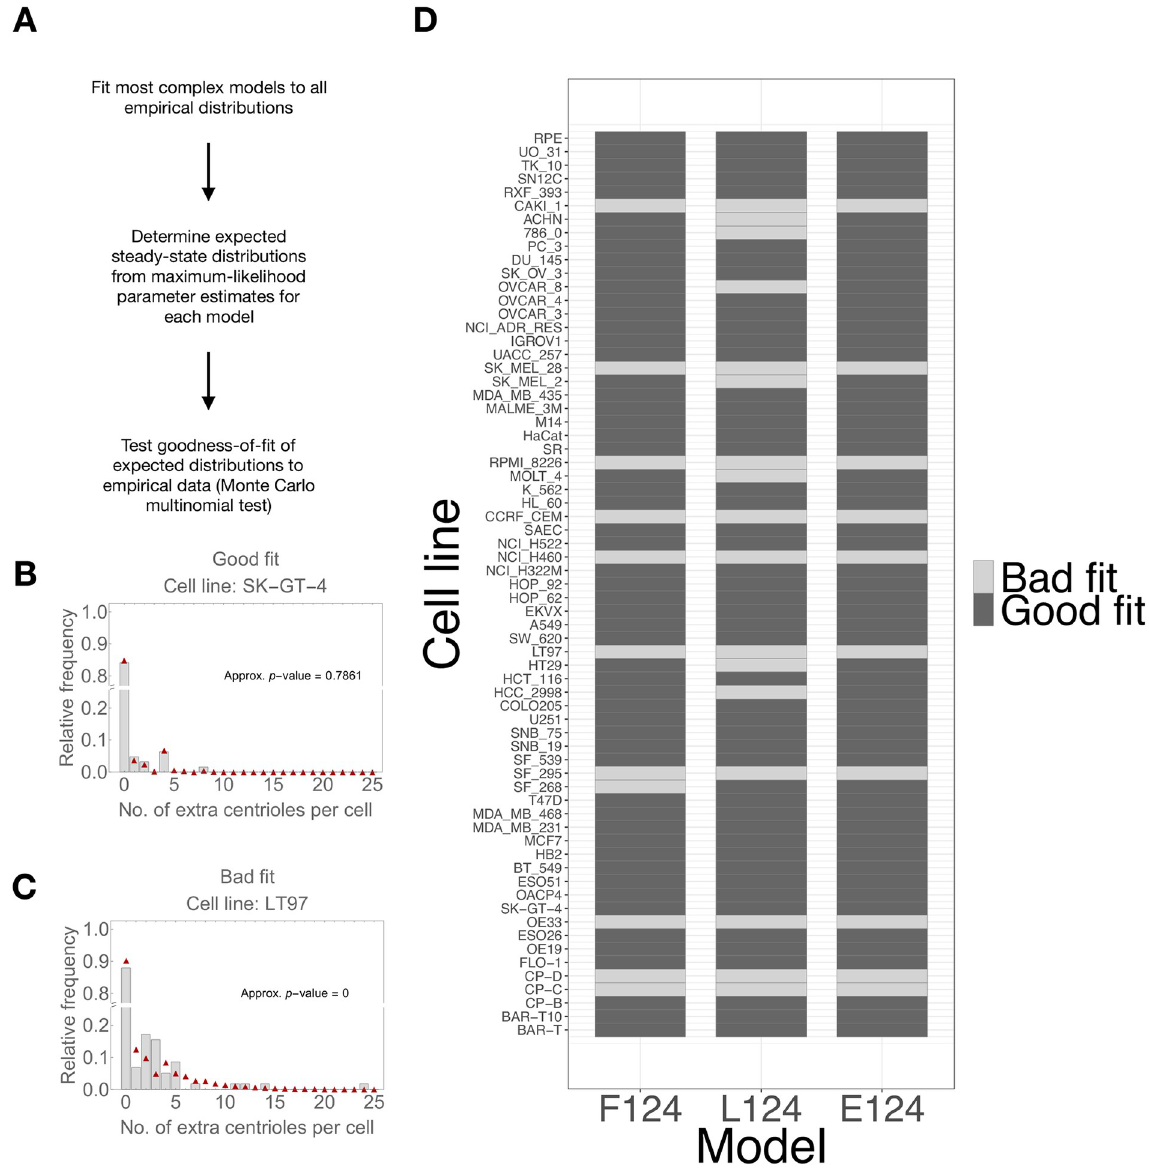
Fig 3. The most complex models are a good fit to the majority of empirical distributions. A—Procedure for determining goodness-of-fit. The significance value was set to α = 0.05, and adjusted according to the Bonferroni correction for 67 tests. Note that under the null hypothesis, the predicted distribution under a given model is identical to the empirical distribution. B-C—Experimentally observed frequencies of centriole numbers per cell (grey bars) and the predicted frequencies under model F124—flat fitness function, single-, double-, and quadruple-step overproduction parameters (red triangles). The two examples include cases in which we obtained non-significant (good fit) and significant (bad fit) p -values. Number of sampled cells: B— n = 82. C— n = 63. D—Goodness-of-fit of the three most complex models for each cell